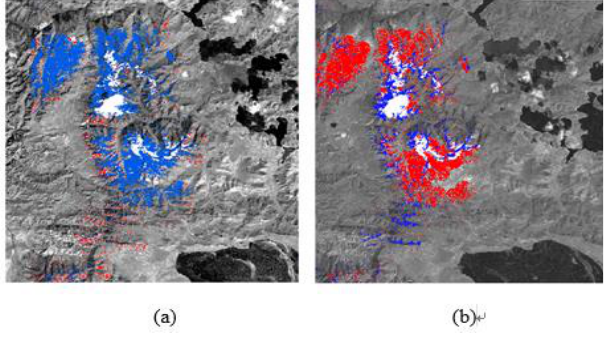
Figure 6. The glacier change detection result